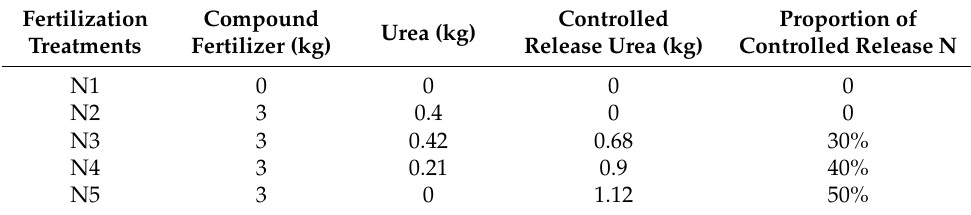
Table 1. Fertilization treatments in the field experiment of